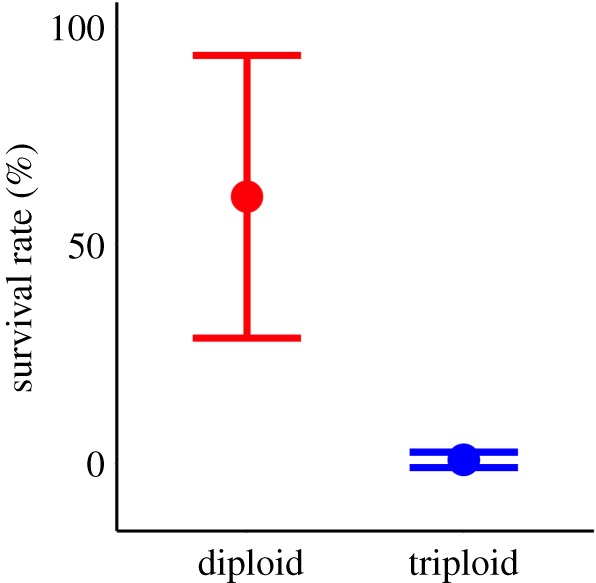
Interval plot of mean survival rates of eggs (±s.e.) to the eyed stage following in vitro fertilization by sperm from either diploid (n = 10) or triploid (n = 10) Atlantic salmon.